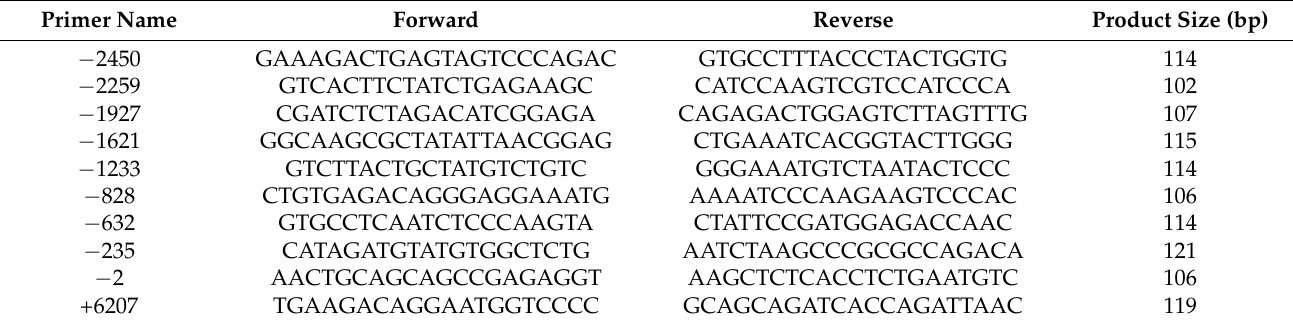
Table 2. Sequences of primers and predicted product sizes for ChIP–qPCR